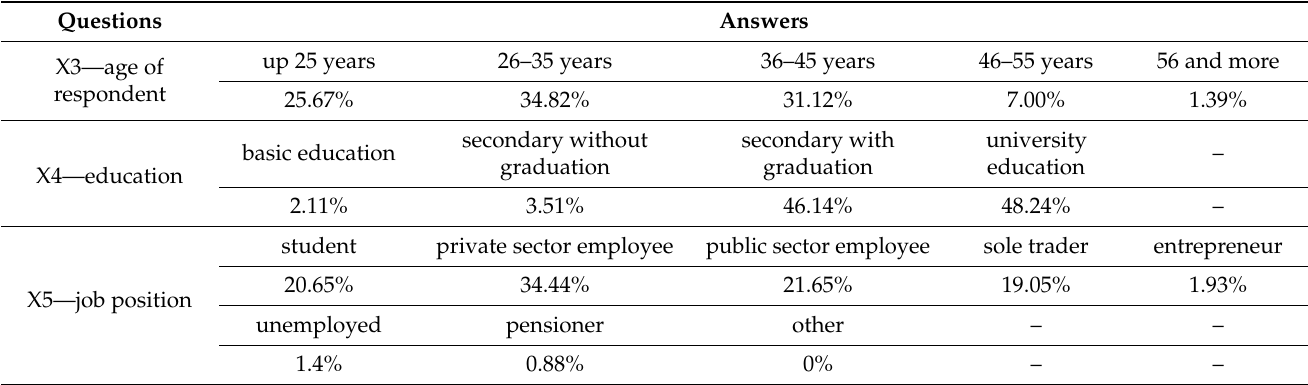
Table 4. Answers of respondents on the questions X3–X5.